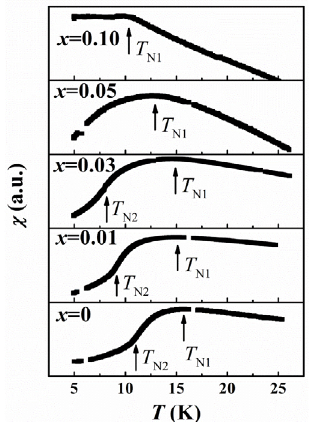
Fig. 10 Expansion of the samples’ χ – T curves in a range of T = 5–25